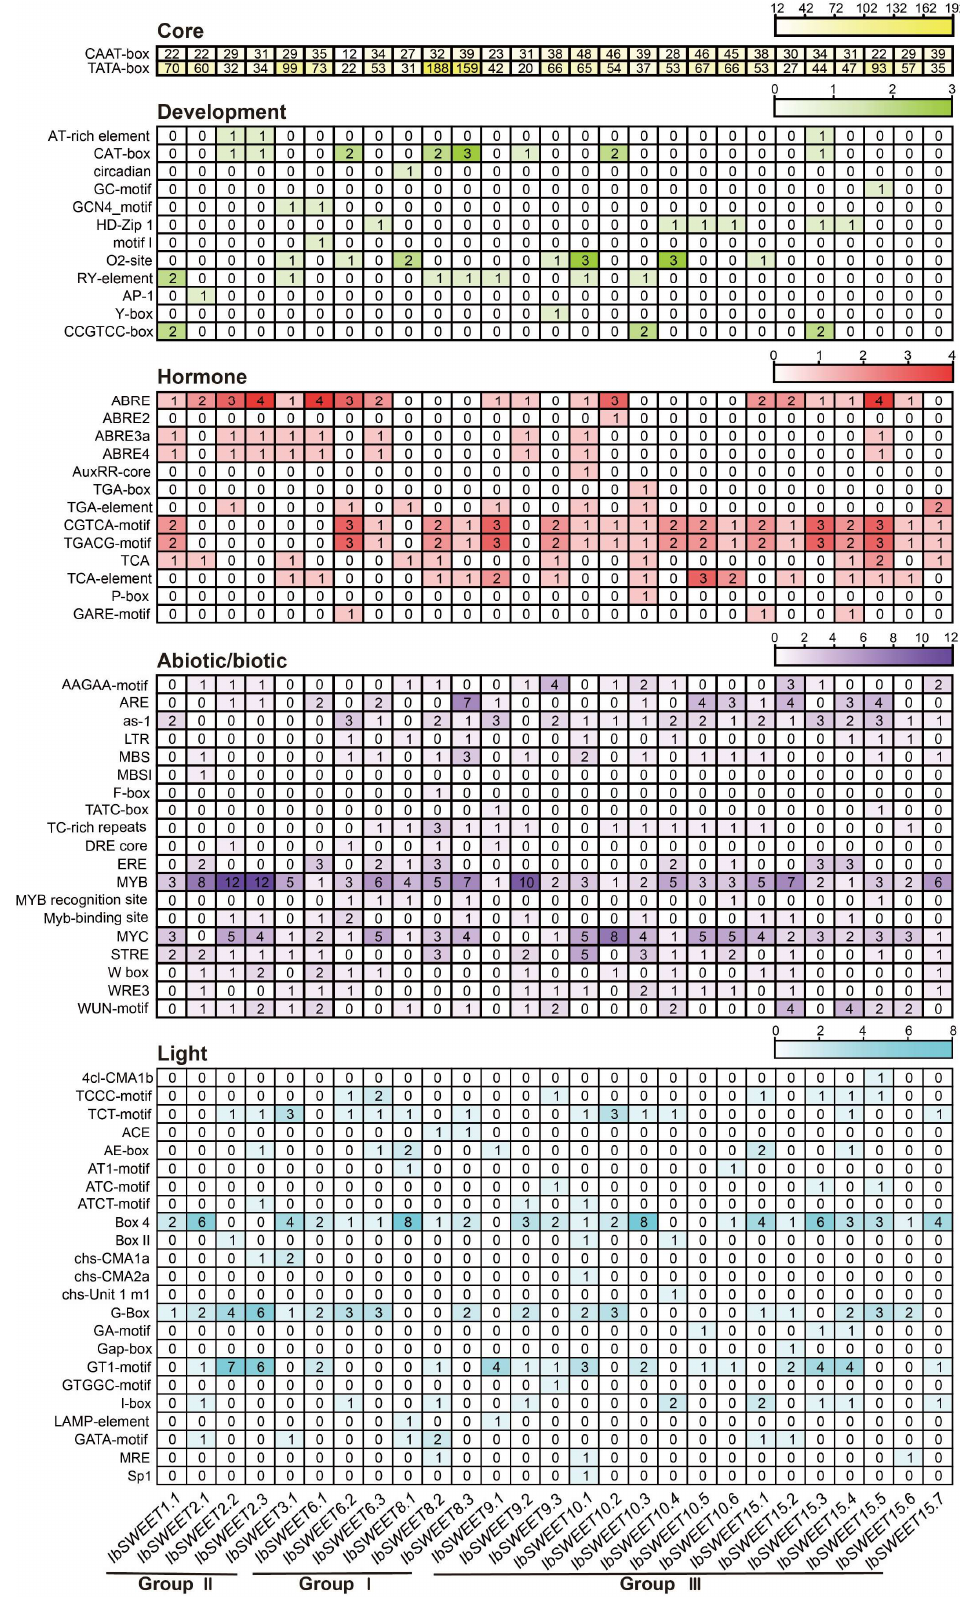
Figure 5. Cis -element analysis of IbSWEET s in I. batatas . The cis -elements were divided into five categories. The intensity of the different colors represents the number of cis -elements in the IbSWEET